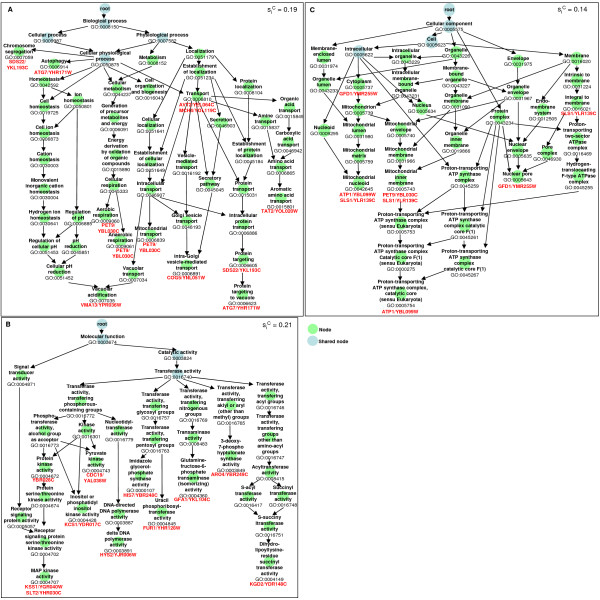
Induced GO graphs for one cluster from each GO aspect for the Snyder data set. Induced GO graphs containing the BP, MF or CC annotation for the proteins found in Snyder (A) BP cluster 3, (B) MF cluster 2, and (C) CC cluster 3, respectively. Nodes found in all of the individual induced GO graphs for the proteins in the cluster are shown in blue. The silhouette width for each cluster (siC) is shown in the upper right hand corner. The medoid protein for each cluster is italicized and underlined.